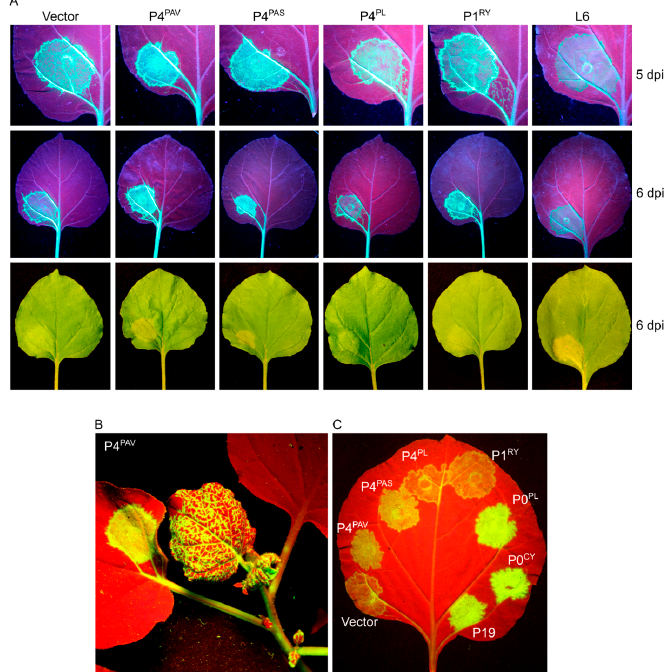
Figure 7. Effects of necrosis induced by luteovirus P4 on virus replication and spread. ( A ) Wild-type N. benthamiana plants were infiltrated with PVX tagged with GFP (PVX-GFP) plus empty vector (vector), BYDV-PAV P4 (P4 PAV ), BYDV-PAS P4 (P4 PAS ), PLRV P4 (P4 PL ), RYMV P1 (P1 RY ) or the fungal resistance gene L6. Pictures were taken either under UV or normal light at 5 and 6 days post-infection (dpi). ( B ) Systemic spread of PVX-GFP co-infiltrated with P4 PAV at 5 dpi. ( C ) Local silencing suppression assay by co-infiltration of PVX-GFP with the empty vector, P4 PAV , P4 PAS , P4 PL , P1 RY , PLRV P0 (P0 PL ), CYDV P0 (P0 CY ) or the TBSV P19.